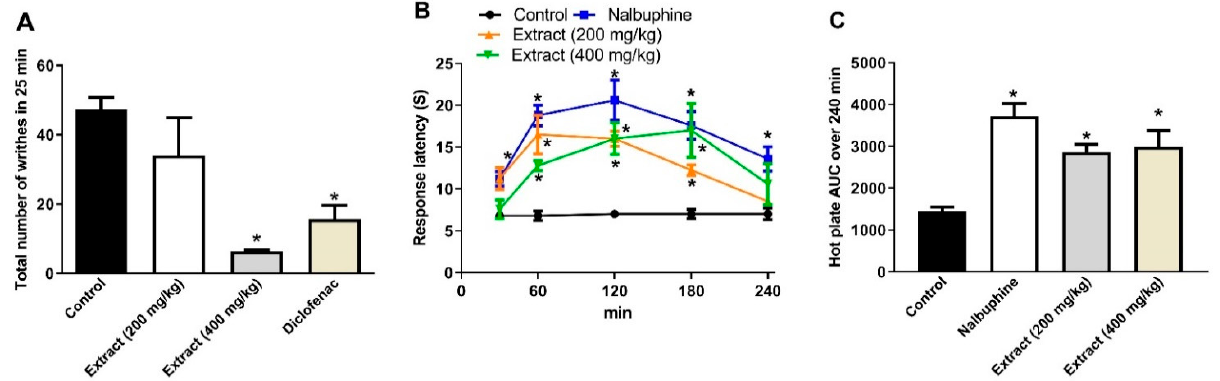
Figure 4. Analgesic activities of P. perfoliatus extract. ( A ) Acetic acid-induced writhing assay. Mice were treated either with the extract (200 and 400 mg/kg, p.o.) or diclofenac (20 mg/kg, p.o.) 1 h prior to the acetic acid (0.7%, 1 mL/100 g) injection. ( B ) Hot plate response latency (s) assay. ( C ) AUC of response latency shown in panel ( B ). The data results were quantified at one-hour intervals after administration of either the extract (200 and 400 mg/kg, p.o.) or nalbuphine (10 mg/kg, p.o.). Results are shown as mean ± S.E.M ( n = 5–8). * p < 0.05 vs. control values.